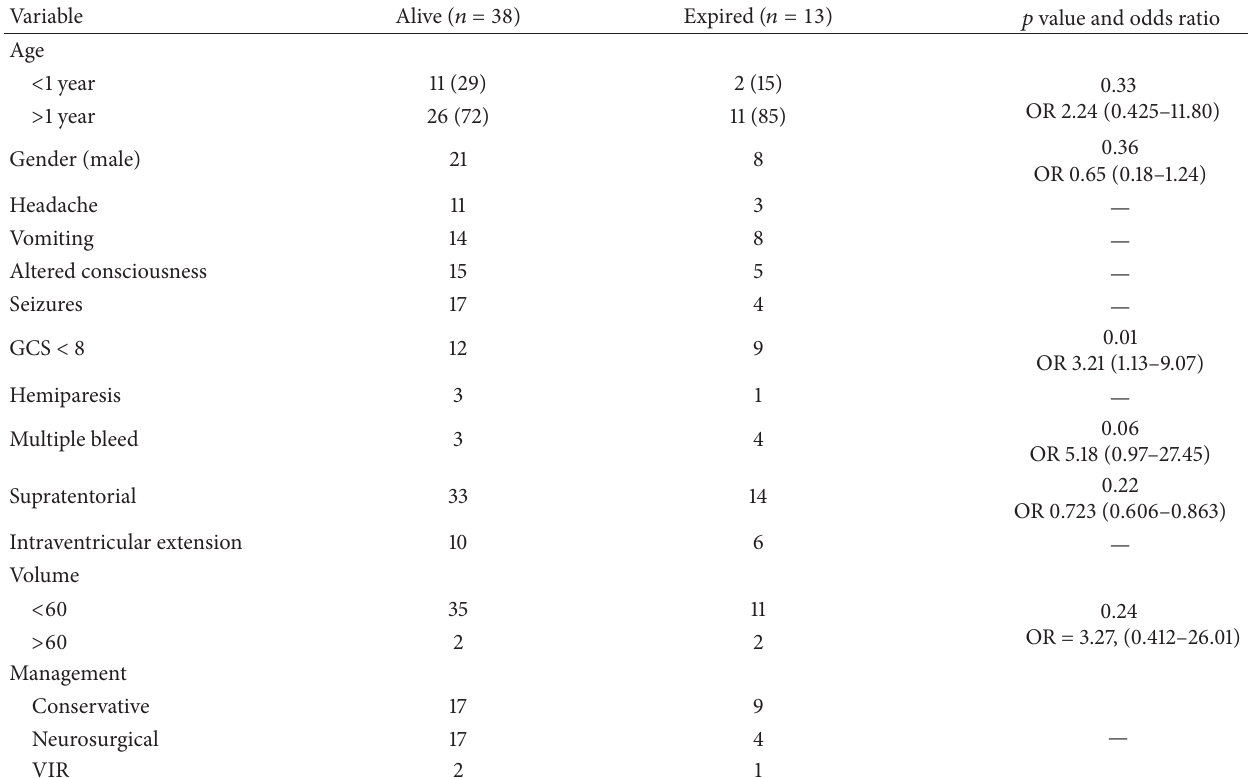
Table 2: Comparison of different variables with outcome ( 𝑛 = 50